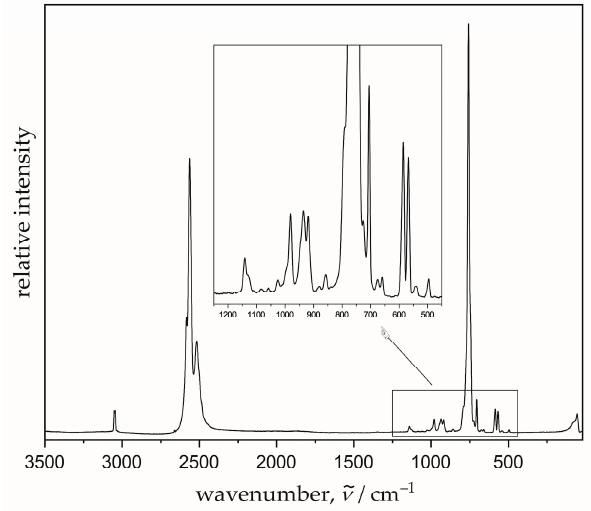
Figure 9. Single-crystal Raman spectrum of Tl[CB 11 H 12 ] recorded at an excitation wavelength of λ = 532 nm.